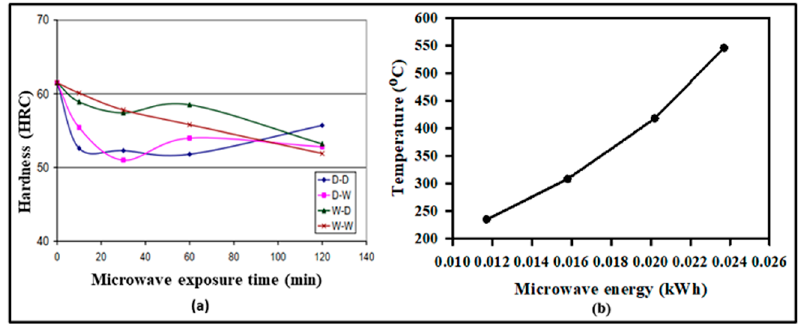
Figure 9. ( a ) Effect of the microwave exposure time on the hardness of granite (reproduced with permission) [61]. ( b ) Response of high phosphorus oolitic iron ore to microwave energy (data source: [34]).